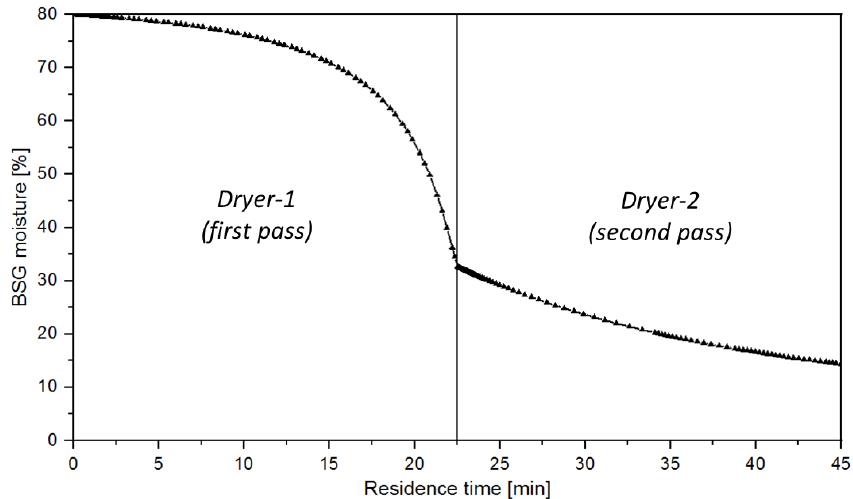
Figure 6. The drying profile along the convective dryer, based on the Aspen Plus simulations for 1010D.